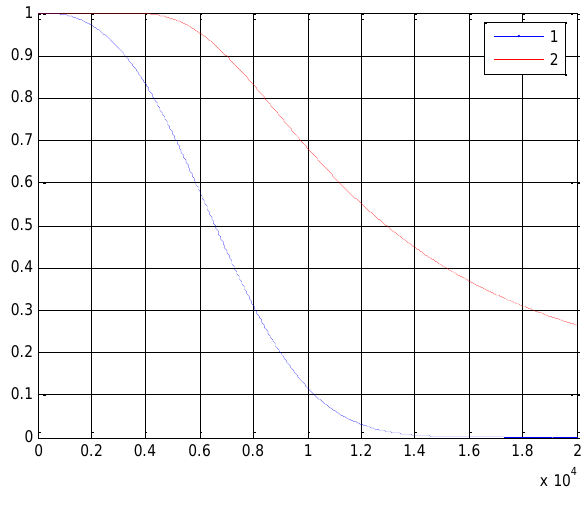
Figure 4. Reliability function of bearing life.